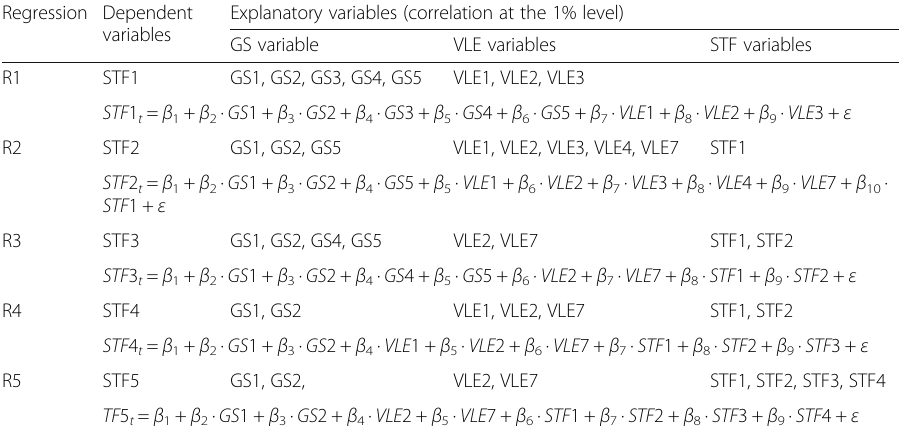
Table 14 Regressions Regression Dependent Explanatory variables (correlation at the 1% level) variables